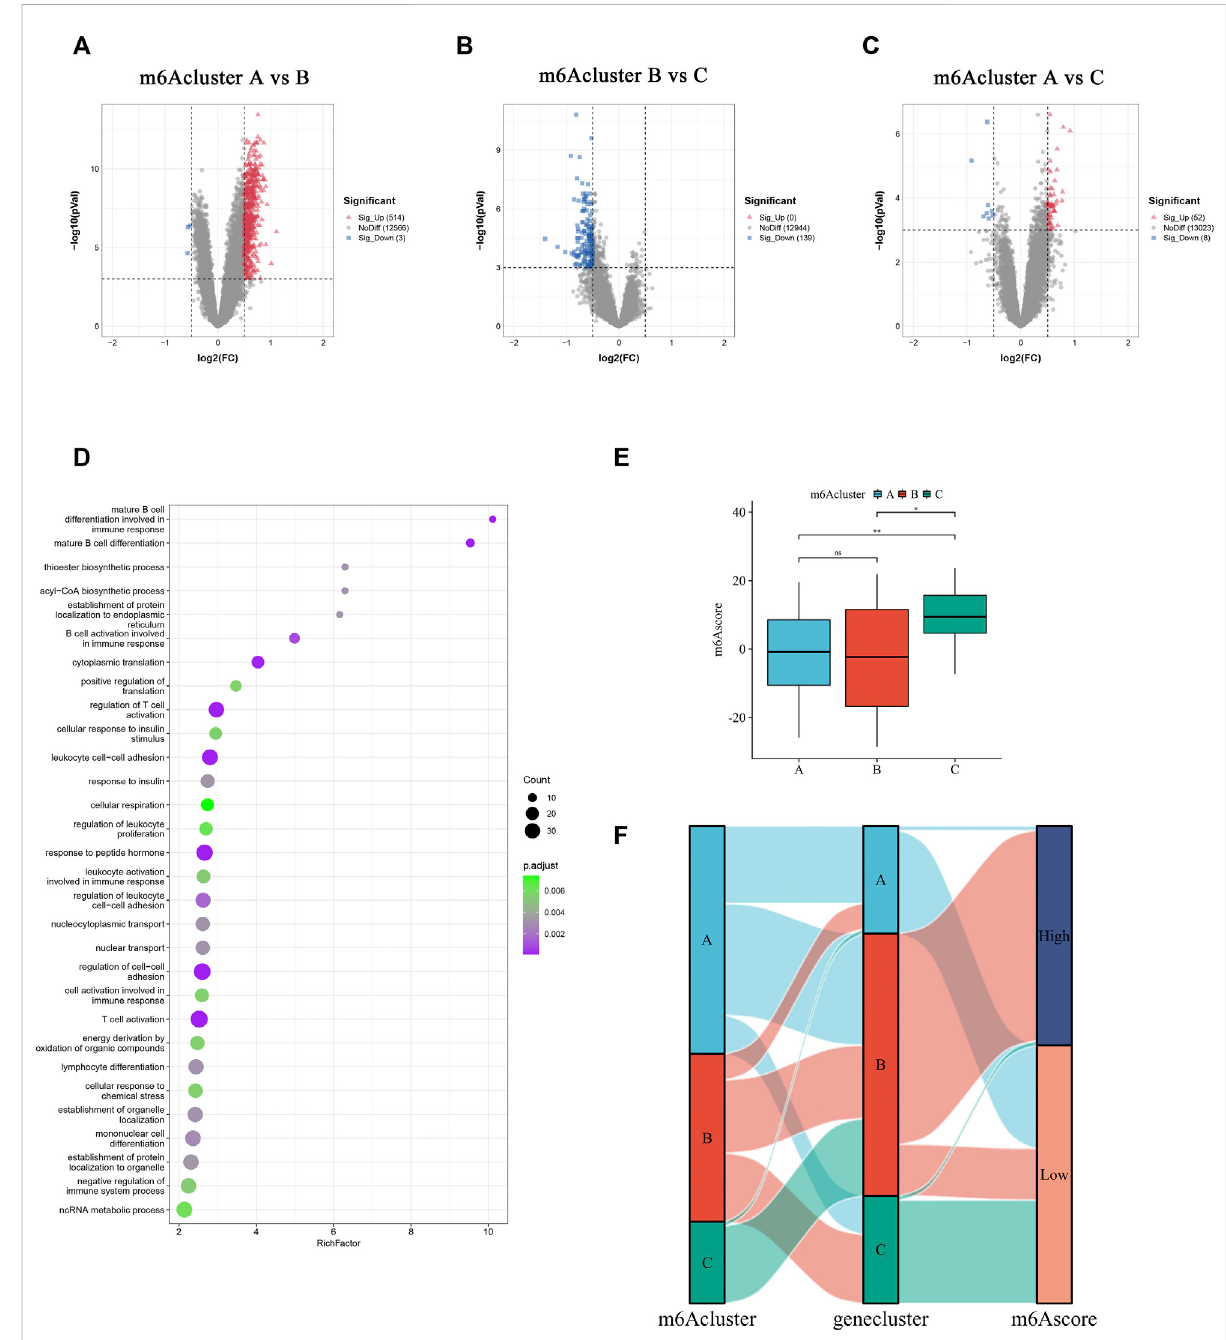
FIGURE 6 GenerationofaquantizedmodelforscoringmethylationsubtypesofindividualAAApatients. (A – C) DEGsbetweenthreem6Aclusters. Theup- regulatedanddown-regulatedDEGsaresignedinredandblue. (D) Thetop30GOenrichmentannotationofDEGs. (E) Comparisonofthem6Ascore indifferentm6Aclusters. (F) Alluvial diagramshowsthealterationinthem6Acluster,geneCluster,andm6Ascoresubgroups.Ns:nosigni fi cance,* p < 0.05, ** p <